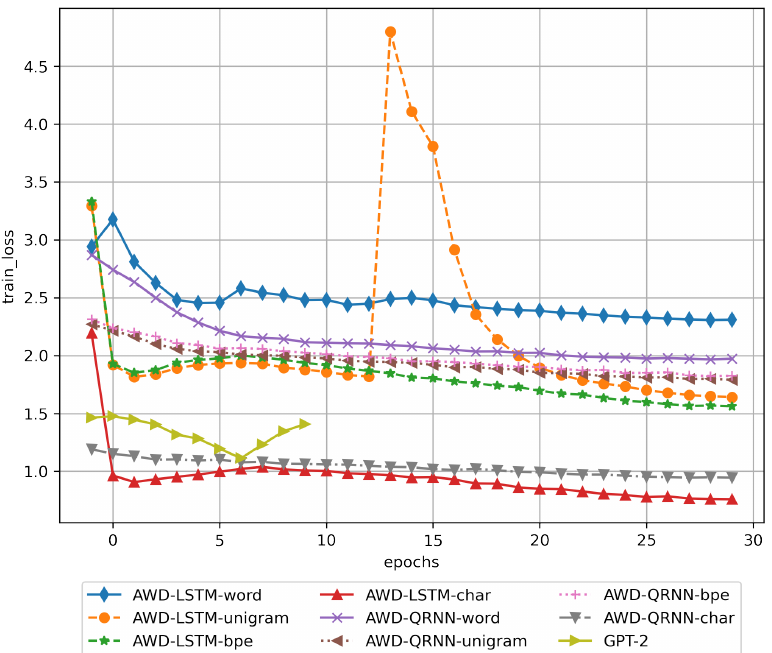
Figure 3. Evolution of the training_loss of DNNs devoted to generating source code during the training epochs.